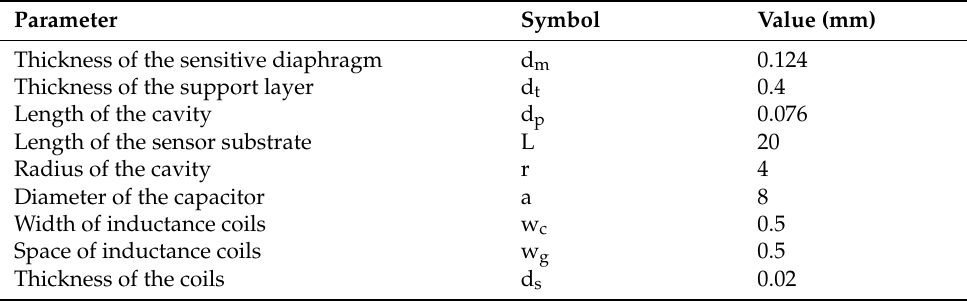
Table 1. Geometrical parameters of the designed LC wireless passive